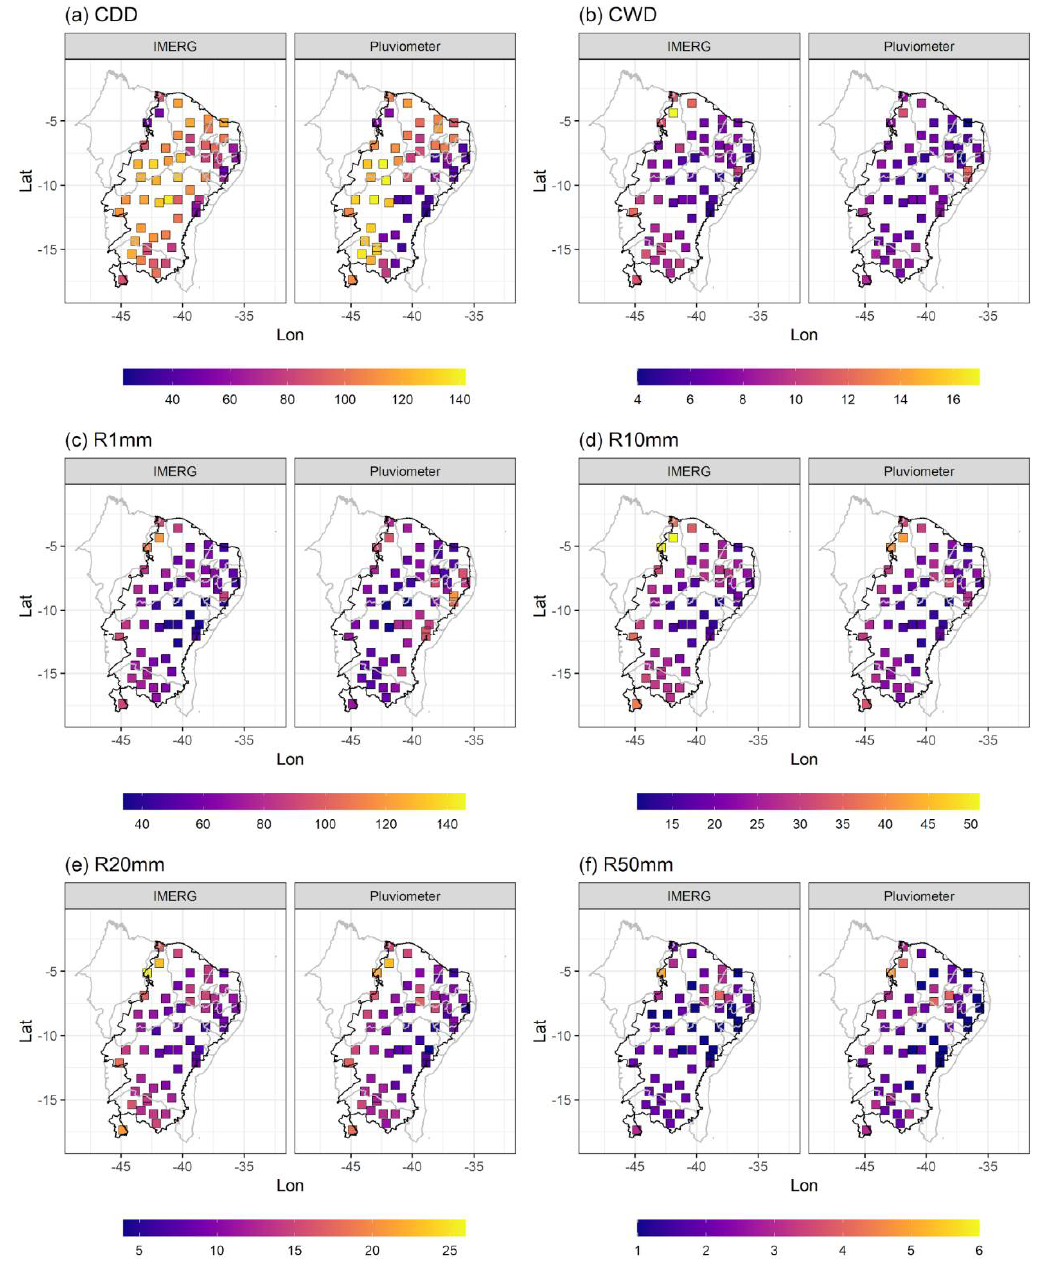
Figure 3. Frequency index (mm/day) of 56 IMERG grid points and INMET rain gauges (2000–2020), ( a ) CDD, ( b ) CWD, ( c ) R1mm. ( d ) R10mm, ( e ) R20mm, ( f ) R50mm.